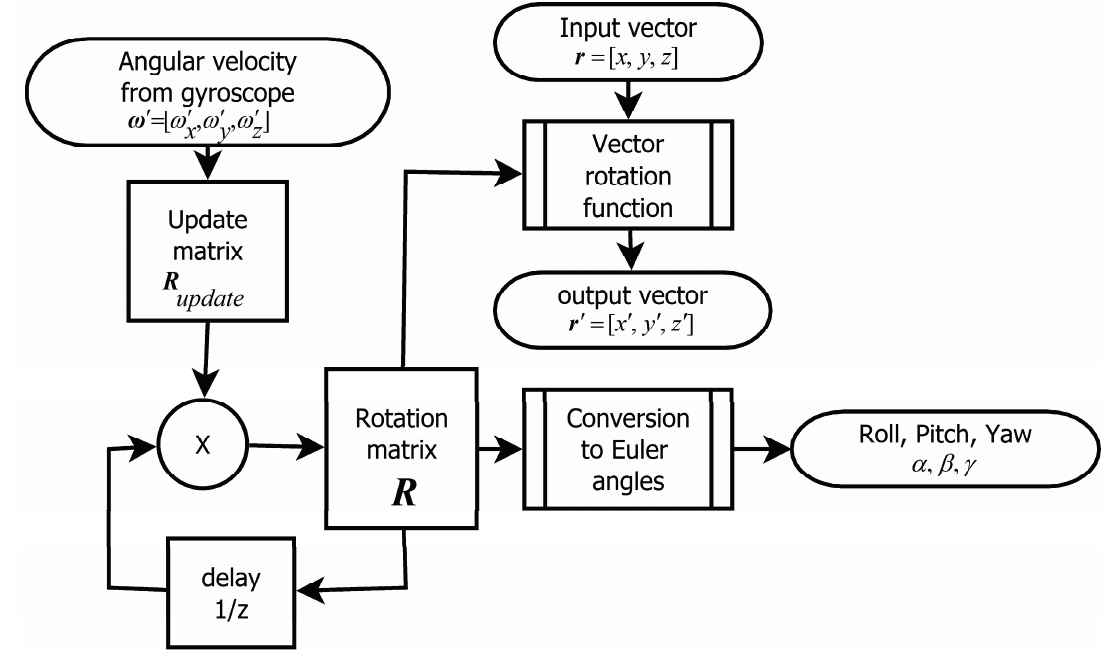
Figure 6. Precise version of the algorithm based on a rotation